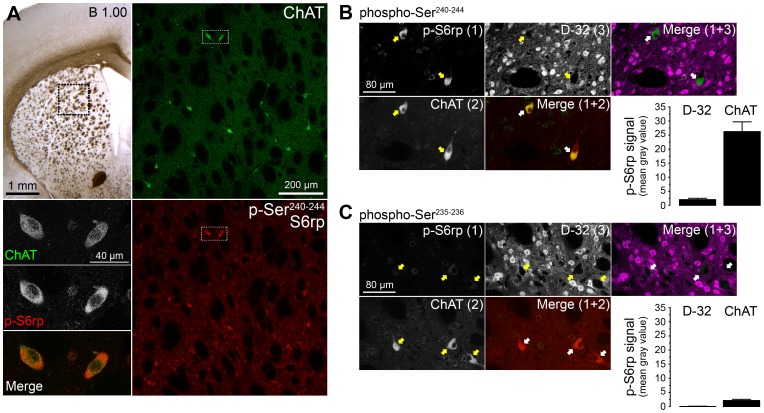
Cholinergic interneurons (CINs) in the striatum show selective phosphorylation of S6rp in basal conditions.(A) Low magnification image from a transcardially-fixed naïve rat brain section showing the striatal level analyzed in the present study. Inset corresponds to magnified right panels: low magnification images of the dorsal striatum double-stained with choline acetyltransferase (ChAT, green) and phosphorylated ribosomal protein S6 at Serine 240 and 244 residues (p-S6rp, red) showing substantial co-localization. Insets (bottom-left) are high magnification confocal images showing ChAT and p-S6rp immunoreactivity in two adjacent CINs. (B, C) Confocal sections of rat striatal tissue stained for two different pairs of phospho-serine residues at the C terminus of S6rp (B, Ser240–244 and C, Ser235–236, green) combined with ChAT (red) and DARPP-32 (D-32, magenta). Arrows indicate ChAT-immunoreactive neurons. (B, C; bottom right graphs) Intensity fluorescence study of p-Ser240–244 (B) and p-Ser235–236 (C) S6rp signal contained in MSNs (D-32 immunoreactive) and CINs (ChAT immunoreactive) in triple-stained sections. Data are mean ± SEM; n = 2 rats; 40 MSNs and 13 CINs quantified per group.